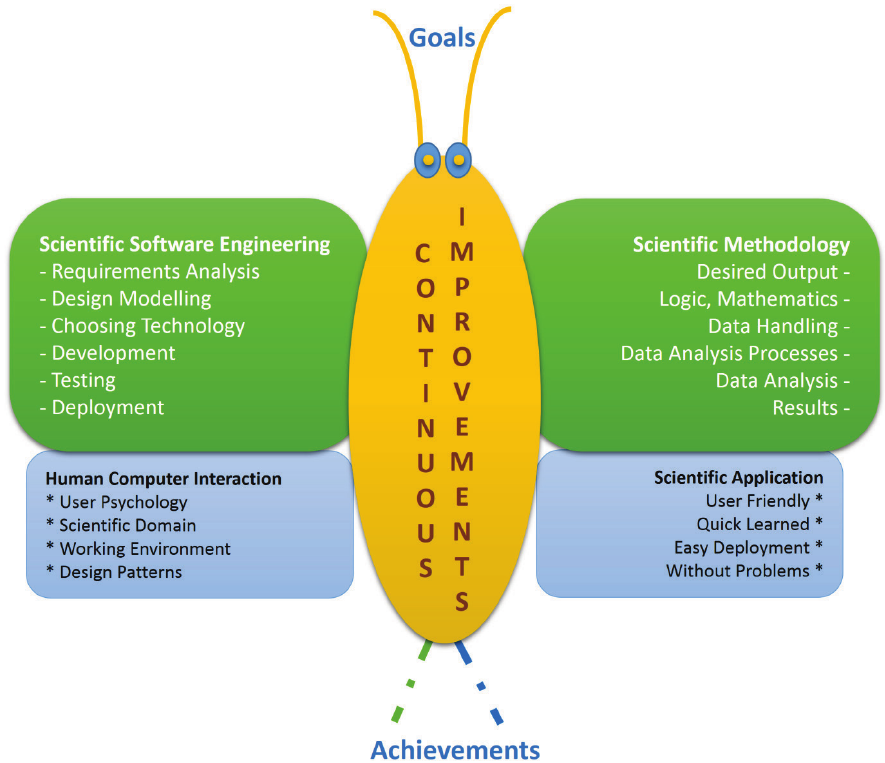
Figure 3. Butterfly model. It consists of four wings: Scientific Software Engineering (upper left), Human Computer Interaction (lower left), Scientific Methodology (upper right) and Scientific Application (lower right). Moreover it leads to continuous improvement (in yellow). The achievements translate the goals into